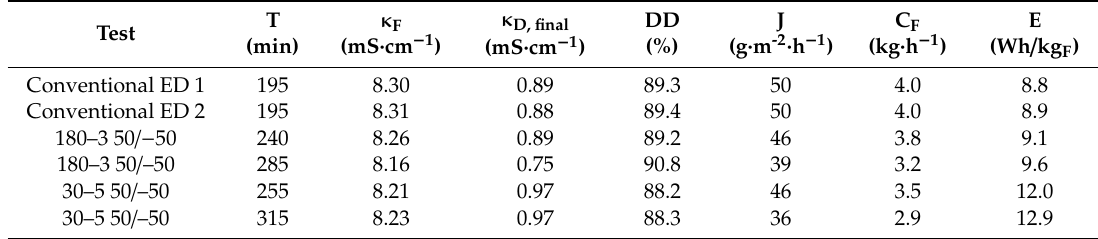
Figure 1. The change in diluate conductivity in different regimes. Table 1. Parameters of acid whey electrodialysis with different regimes of applied potential (two consecutive runs without CIP).